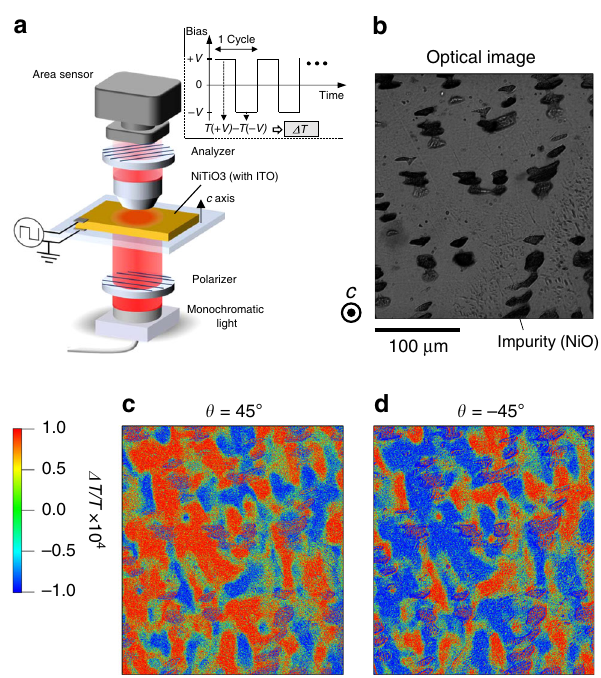
Fig. 4 Spatial distribution of ferroaxial domains obtained via electrogyration in NiTiO 3 . a Experimental setup of electrogyration measurement using a difference image-sensing technique. Inset of ( a ) shows temporal evolution of applied voltage V during the measurement. Microscopy images of transmitted light were captured by the area sensor while the positive and the negative V applied. The difference of transmittance between the positive- and negative-voltage images ( Δ T ) divided by the average of them ( T ) was calculated for each pixel detection, and then spatial distributions of Δ T/T were obtained. b Transmission optical microscopy image with the incidence of light along the c axis (Scale bar: 100 μ m). Dark areas in the image correspond to NiO impurity. c, d The two-dimensional maps of Δ T/T , which corresponds to electrogyration, at the same area as panel b . A 3 × 3 median fi lter was applied to the raw images. The polarization direction of the analyzer was set at ( c ) θ = + 45° and ( d ) − 45° with respect to that of the polarizer. These measurements were done under V = ±100 V at room temperature, that is, in the R (cid:1) 3 ferroaxial phase. A Δ T/T color scale is applied to the images in panels c and d . Red and blue regions correspond to either A + or A − ferroaxial domains. Purple-colored regions represent areas of NiO